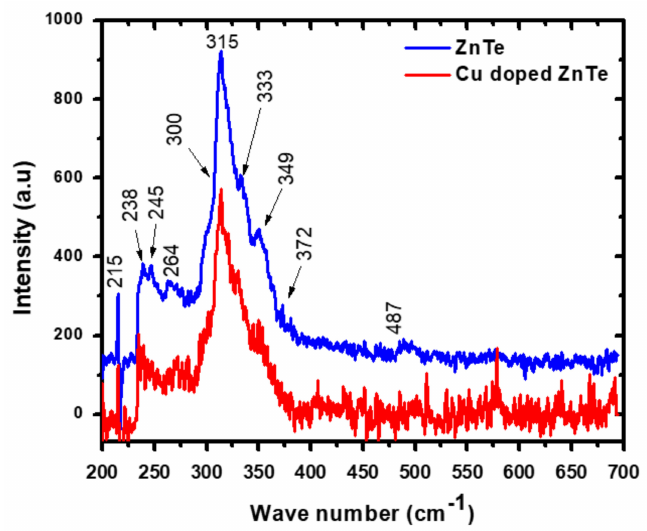
Figure 3. Room temperature Raman spectra of un-doped ZnTe and Cu-doped ZnTe thin film